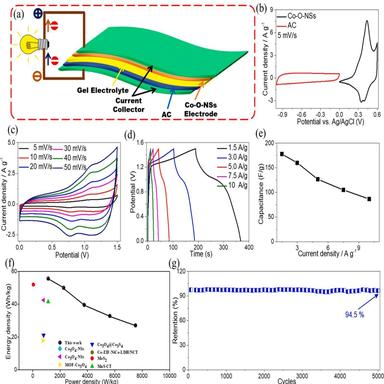
Electrochemical characterization of f-Co-O-NSs@CFC||AC in a two-electrode configuration: (a) Schematic illustration of the flexible SC, (b) CV profiles of both anode and cathode at 5 mV/s, (c) CV profiles at various scan rates, (d) GCD profiles at various current densities, (e) Specific capacitance as a function of current density. (f) Ragone plot and comparison with recently reported work, and (g) Long-term cycling stability test.